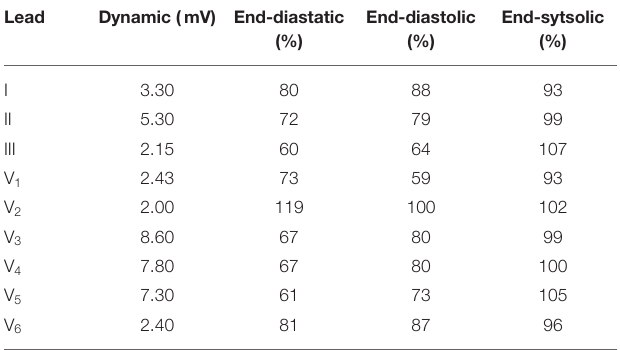
TABLE 1 | T-Wave amplitude of the dynamic configuration in the standard leads and the respective differences of the three static cases in respect to the dynamic one.